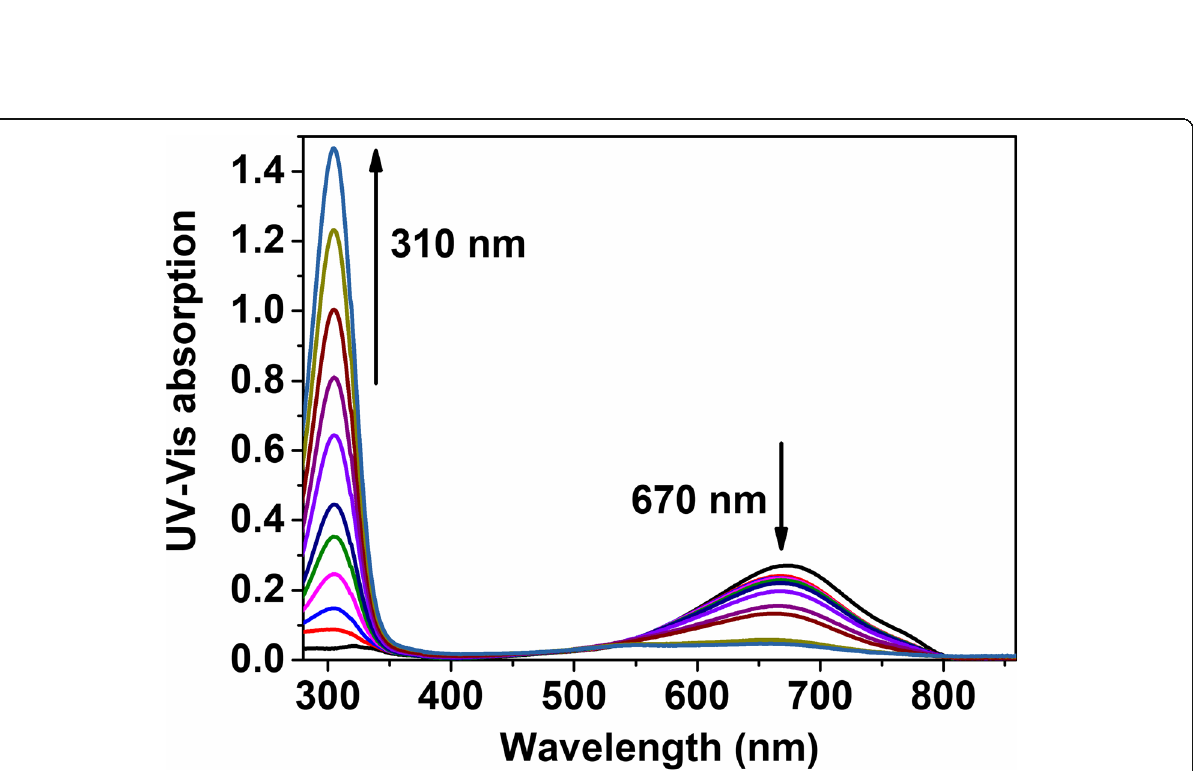
Fig. 4 UV-Vis spectrum of probe 1 upon adding of Ag + (0, 0.05, 0.1, 0.5, 1.0, 2.0, 3.0, 4.0, 5.0, 6.0, 7.0 μ M) in HEPES buffer solution (pH